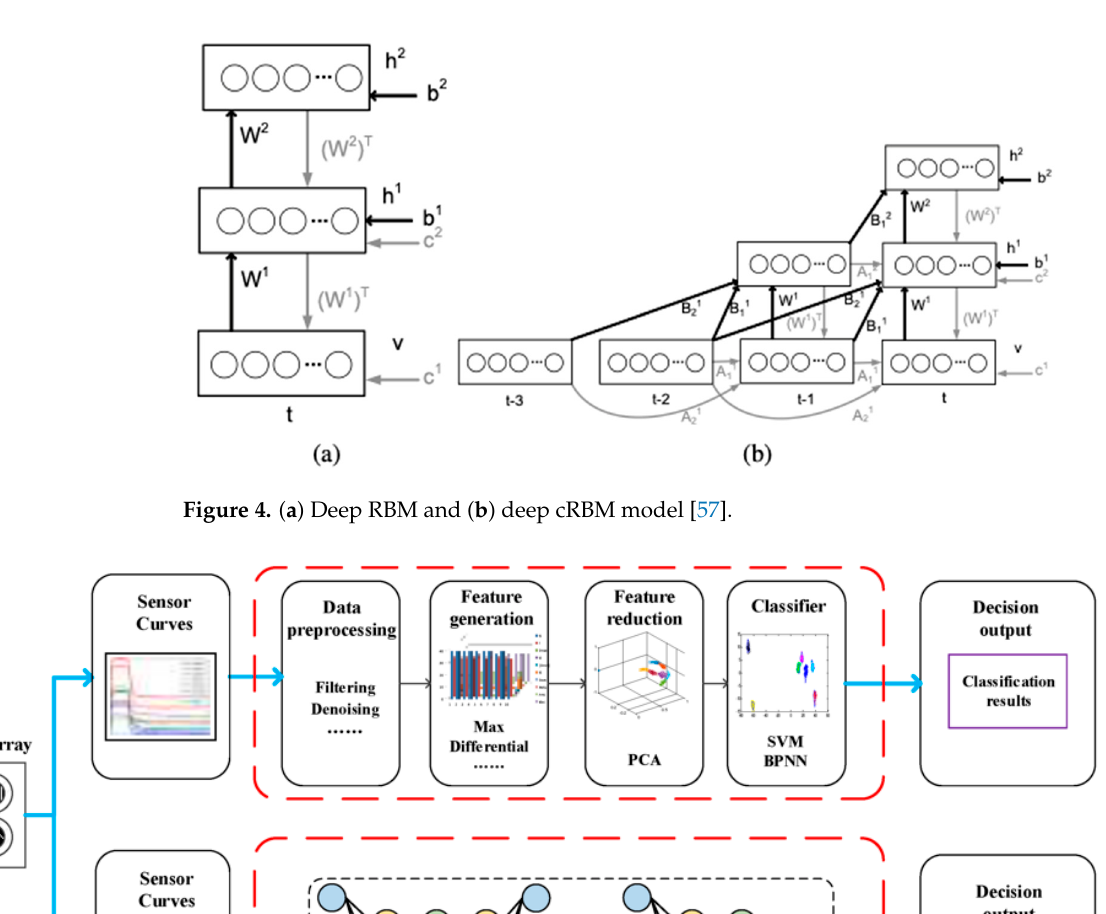
Figure 4. ( a ) Deep RBM and ( b ) deep cRBM model [57].